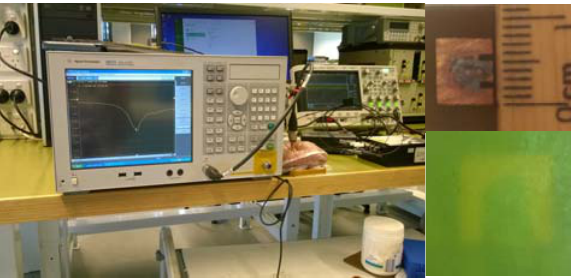
Figure 7. Measurement setup and proposed PIFA on FR4